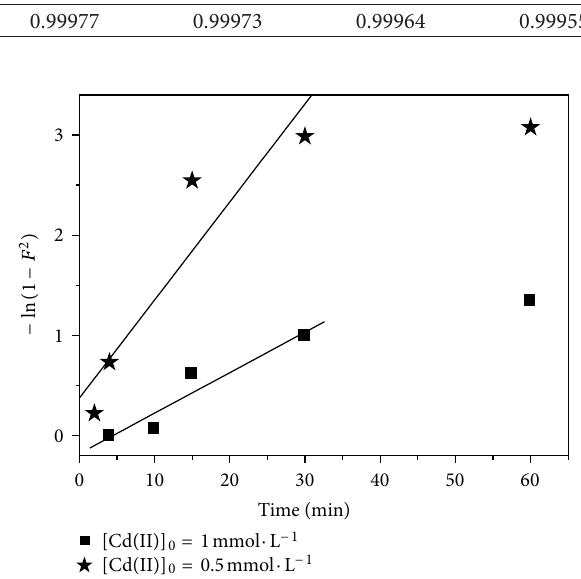
F 7: Plot of (11) for Cd(II) adsorption on graed resin, m = 0.030g, V = 5mL, and initial pH = 5.0.